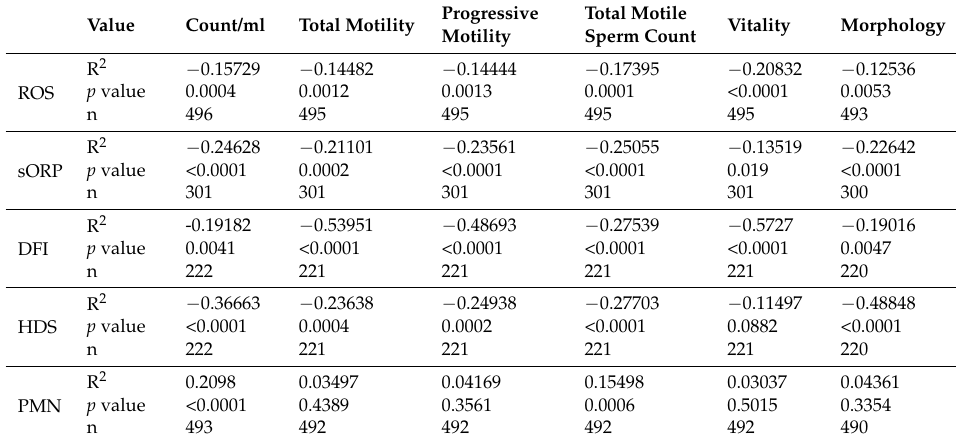
Table 4. Correlation between oxidative stress, sperm genetic integrity and semen parameters.